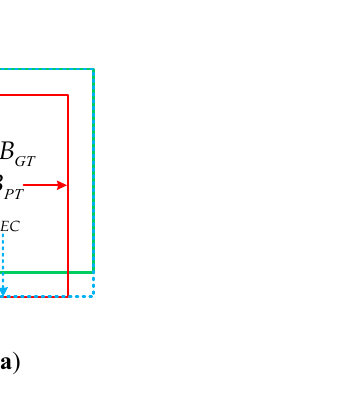
Figure 2. Illustration of two intersecting (non-overlapping) bounding boxes. (a) Two intersecting bounding boxes; (b) Two non-overlapping bounding boxes. The rectangles enclosed by a green solid line, red solid line, and blue dashed line separately denote the ground truth box B GT , predicted bounding box B PT , and smallest enclosing box B EC